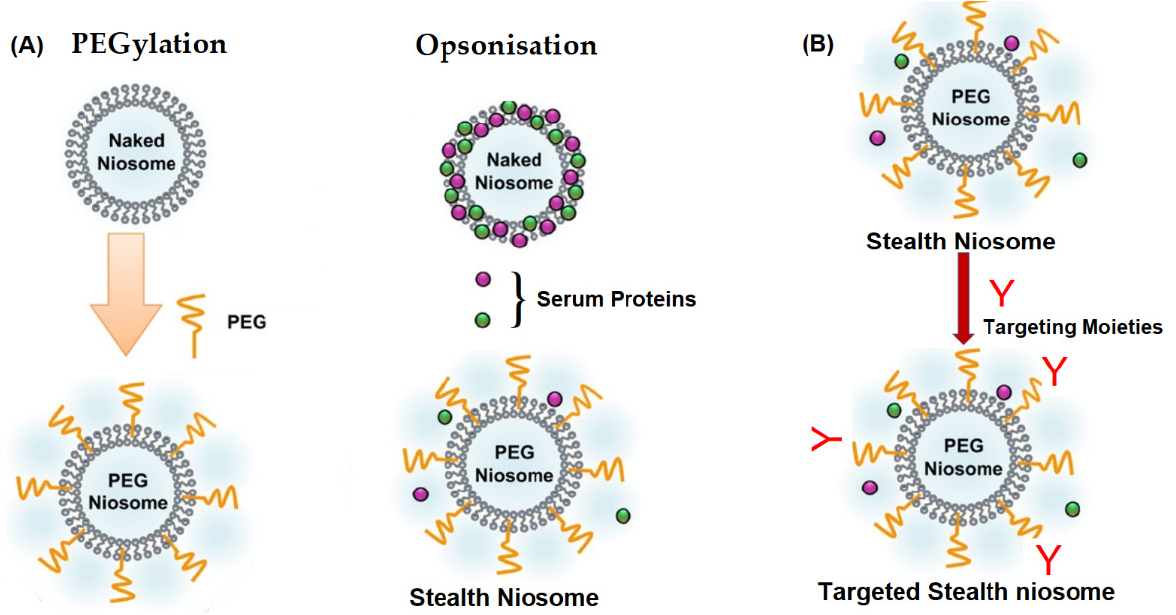
Figure 6. Schematic representation of ( A ) naked and PEGylated niosome interactions with serum proteins and ( B ) targeted stealth niosomes. (Adapted from [108] with permission from Elsevier, Amsterdam 2022).